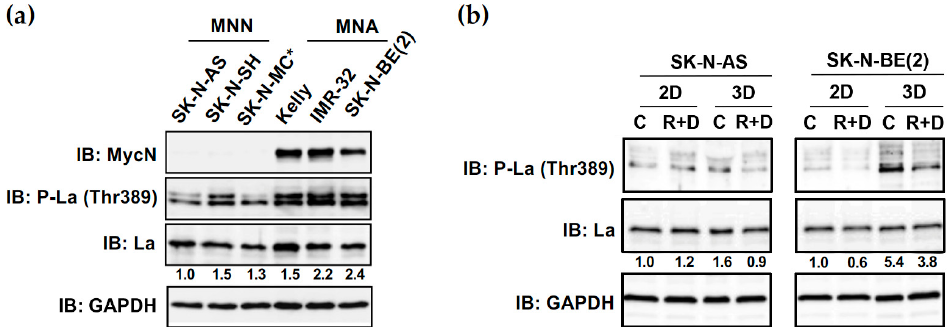
Figure 10. R+D ‘pre-treatment’ reduced augmented Thr389 phosphorylation of RNA-binding protein La in NB spheroids. Immunoblot (IB) analysis indicates ( a ) the expression level of oncogene MycN and the La protein as well as the phosphorylation status of La at threonine 389 (Thr389) in various neuroblastoma cell lines (SK-N-AS, SK-N-SH, Kelly, IMR-32, SK-N-BE(2)) and SK-N-MC*. grown in 2D monolayer cultures in medium supplemented with 10% FBS. The star (*) indicates that SK-N-MC has been originally described as neuroblastoma but is now widely regarded as an Askin‘s tumor cell line related to Ewing‘s sarcoma [47]. In ( b ), the phosphorylation status of La at Thr389 is depicted, comparing 2D and 3D cultures under control (vehicle)- and Rapamycin plus Dasatinib (R+D)-treated conditions. Cells were grown in medium supplemented with 5% KOSR. Numbers below bands state phosphoprotein (P-La (Thr389)) normalized to total La protein expression. GAPDH was applied as loading control. C: Vehicle-treated control cells. R+D: Rapamycin plus Da- satinib treatment as depicted in Table 2. MycN-non-ampli fi ed (MNN), MycN-ampli fi ed (MNA). IB: Immunoblot. Original immunoblot (IB) images (Figure S4). 4. Discussion New treatment strategies are urgently needed for high-risk children with relapsed or treatment-refractory neuroblastoma. Targeting relevant signaling pathways—such as the neoplastic PI3K/Akt/mTOR pathway —r evealed promising e ffi cacy in monolayer NB cell cultures, and corresponding therapeutic agents were tested in various clinical trials [43]. However, these promising preclinical results could often not be translated into the clinic